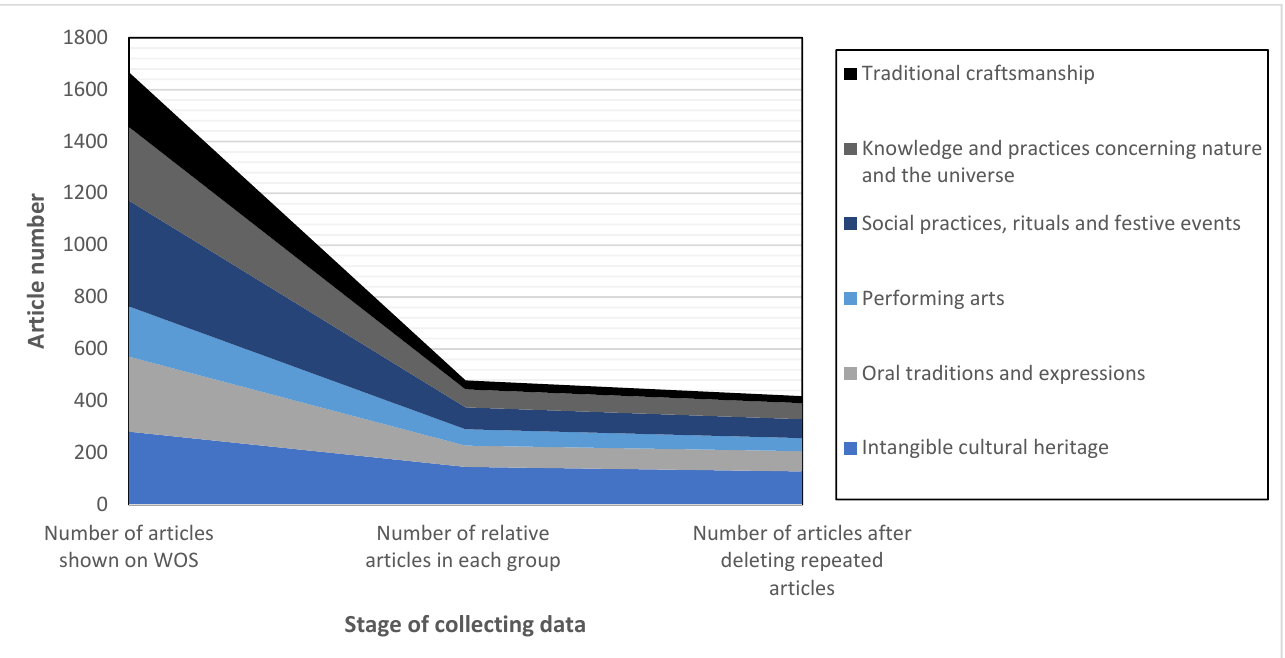
Figure 1. Number of papers by selecting step and category. Source: edited by authors.